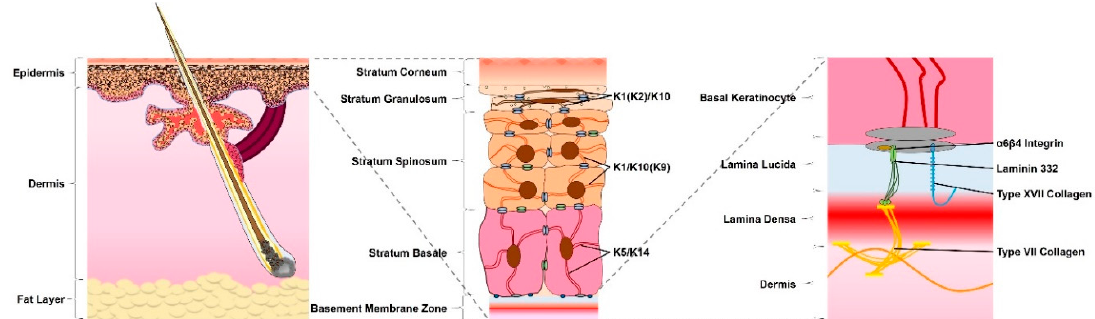
Figure 1. The anatomy of the skin. The skin consists of three layers: fat, dermis and epidermis. The epidermis is typically composed of four layers, situated above the basement membrane. From inner to outer, these are: the stratum basale, stratum spinosum, stratum granulosum and stratum corneum—associated with different expression profiles with respect to keratins and intracellular adhesions. Keratins 5 and 14 (K5/K14) are expressed in basal cells. Suprabasal cells demonstrate a downregulation of K5/K14 in favor of K1/K10 in normal interfollicular epidermis and K1/K9 in the palms and soles. Cells of the stratum granulosum additionally express K2. The basal keratinocytes of the stratum basale connect the epidermis to the basement membrane zone, comprised of the lamina lucida and lamina densa, which provides connection between the epidermis and the underlying dermis. Structural proteins within the basement membrane zone, such as α 6 β 4 integrin, laminin 332, type XVII collagen and type VII collagen, are crucial for the integrity and stability of the skin.